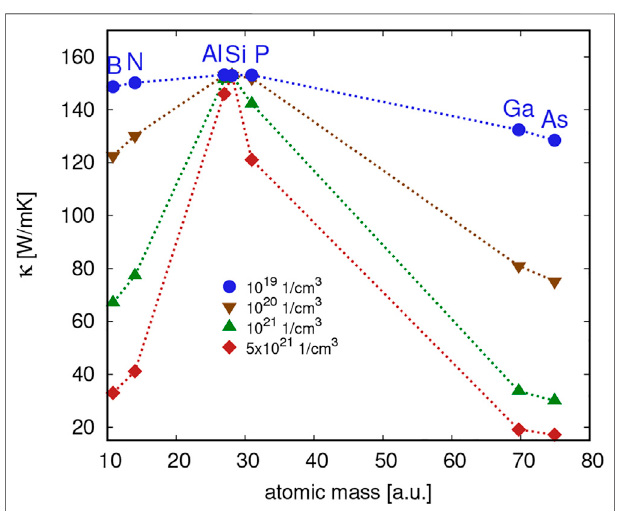
FIGURE7| ThermalconductivityinSiasafunctionoftheatomicmassof the dopant for various doping concentrations.